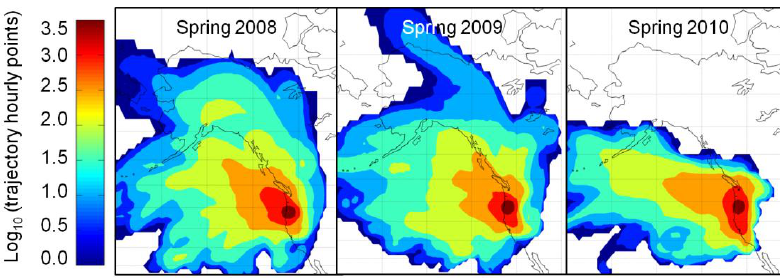
Fig. 3. Horizontal distribution of air mass transport to MBO during the period 1 April – 20 May for 2008, 2009, and 2010. These maps were created from 10-day HYSPLIT backward trajectories initialized from MBO each hour. The colors represent the number of points within a 200km radius of each latitude and longitude point. Note the log scale.